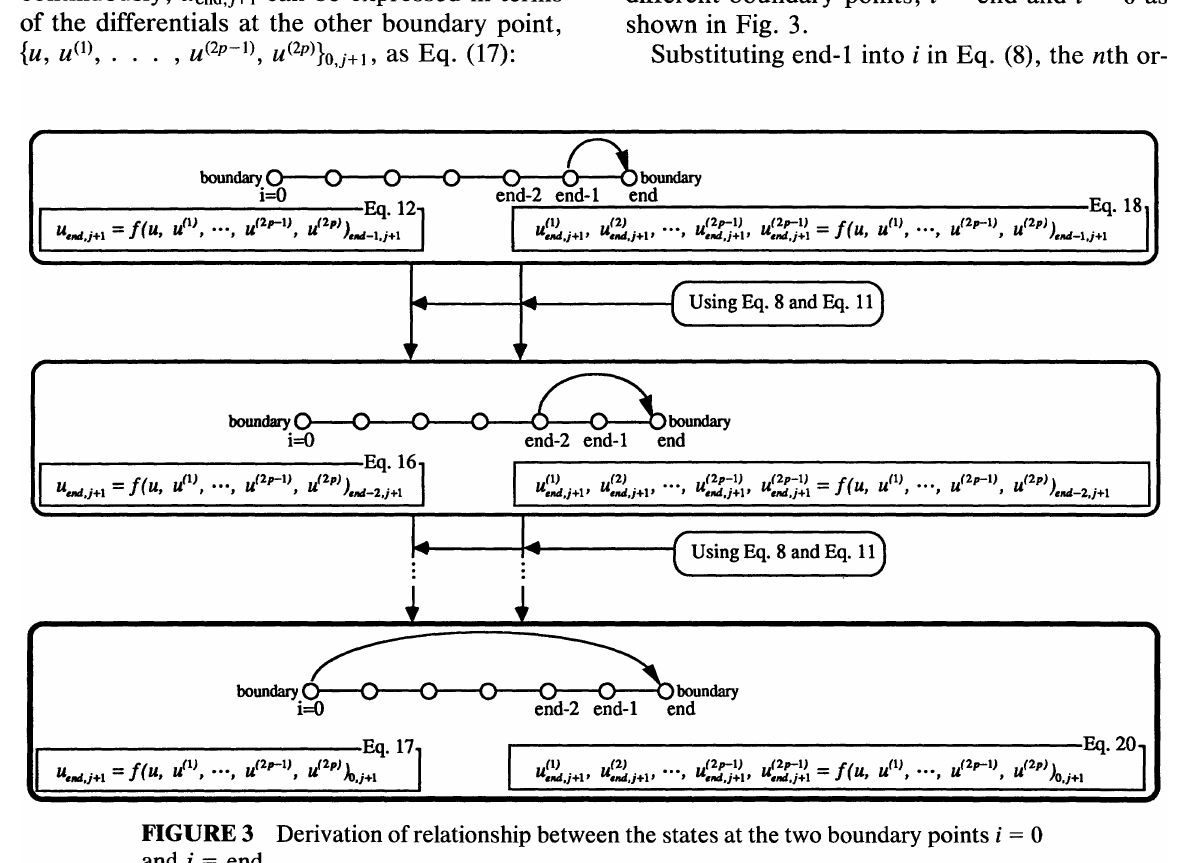
FIGURE 3 Derivation of relationship between the states at the two boundary points i = 0 andj =